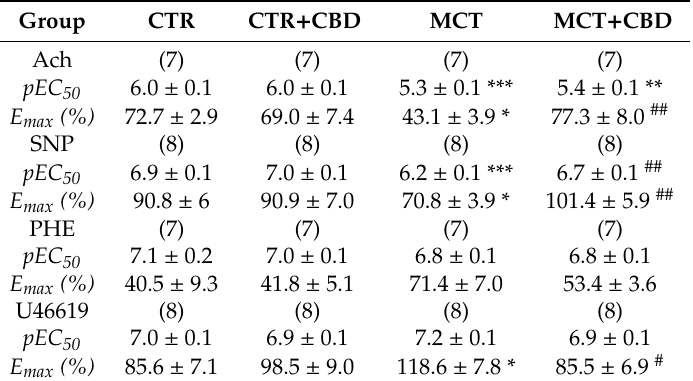
Figure 3. The effect of chronic administration of cannabidiol (CBD) on the vasorelaxant responses to acetylcholine (Ach) ( A ) and sodium nitroprusside (SNP) ( B ) and vasoconstrictor effects of phenylephrine (PHE) ( C ) and thromboxane A 2 analogue (U46619) ( D ) in the pulmonary arteries of control (CTR) and monocrotaline (MCT)-induced pulmonary hypertension. CBD 10 mg/kg or its vehicle was injected intraperitoneally every 24 h for 21 days. Vasodilator and contractile responses are shown as a percentage of the isometric contraction induced by U46619 ( A , B ), and of the reference response to KCl ( C , D ), respectively. Data are presented as mean ± SEM ( n = 7–8) tissues for each curve. In a few cases, SEM is smaller than or equal to the size of the symbols. See Table 1 for statistical analysis. Table 1. Influence of chronic administration of cannabidiol on the vasorelaxant effects of acetylcholine (Ach) and sodium nitroprusside (SNP) and vasoconstriction effects of phenylephrine (PHE) and thromboxane A2 analogue (U46619) in the pulmonary arteries of control (CTR) and monocrotaline (MCT)-induced pulmonary hypertension.